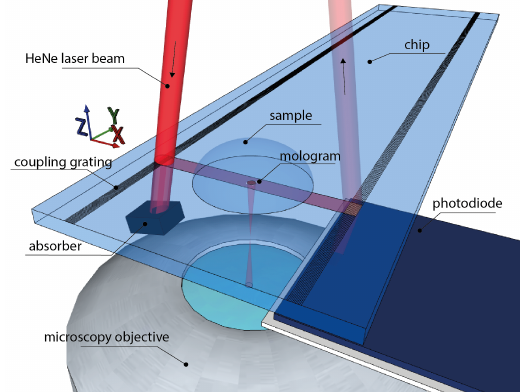
Figure A1. Sensor arrangement: the beam of a Helium-Neon (HeNe 632.8 nm) laser impinges onto a coupling grating that couples the optical power into the guided TE mode of a 2D slabwaveguide that sits on a glass substrate. The guided mode illuminates a molecular hologram (400 µ m diameter, 0.1 NA), which diffracts a tiny amount of the incident optical power into a diffraction-limited Airy disk that is monitored by a 0.1 NA objective. At the other end of the chip, an outcoupling grating in combination with a photodiode is used to measure the outcoupled